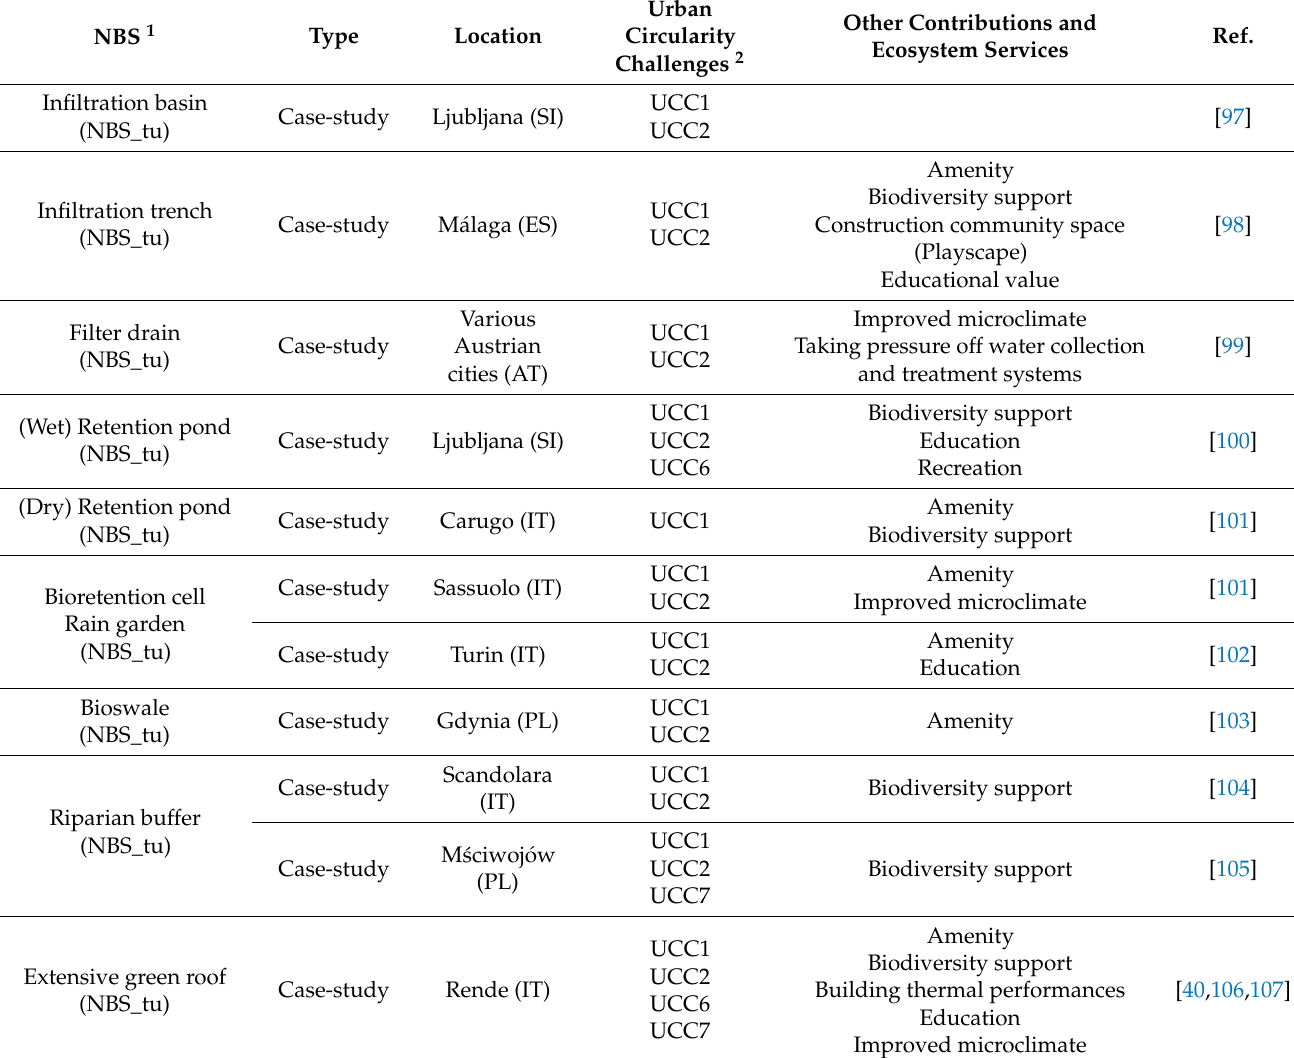
Table A1. Case-studies, models, theories, and lab-scale of representative NBS units, exemplifying their contribution to the urban water management and the circularity challenges (UCC). Urban NBS 1 Type Location